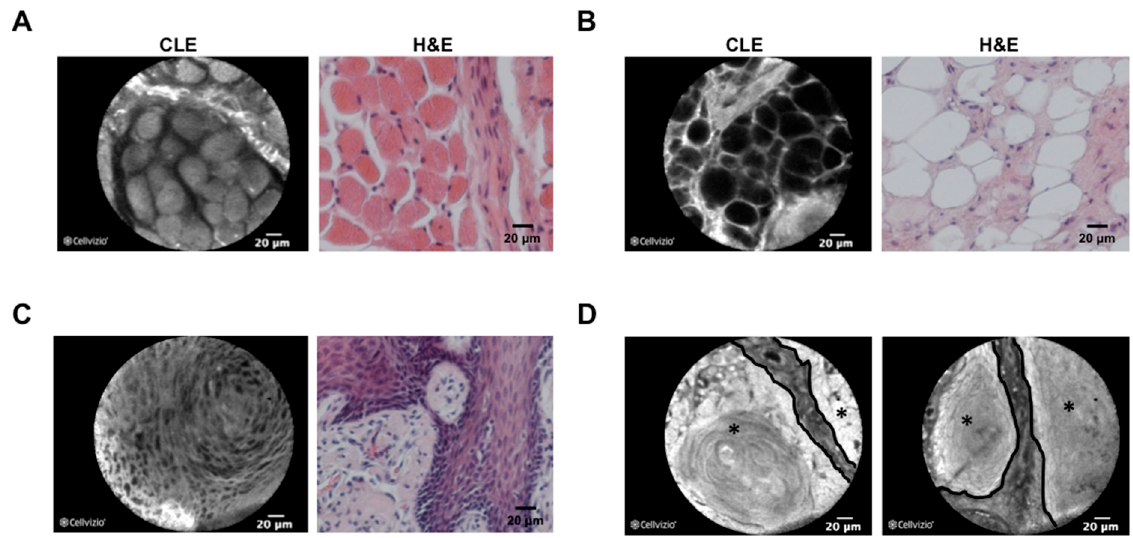
Figure 3. Comparison between CLE and H&E morphology of tissue in the head and neck area. Confocal laser endomicroscopy (CLE) images (left picture, fresh frozen samples) and H&E-stained slides from the respective FFPE tissue are shown for skeletal muscle of the soft palate ( A ), adipose tissue of the cheek ( B ), a nonkeratinizing squamous cell carcinoma of the tonsil ( C ) and a keratinizing squamous cell carcinoma of the tongue ( D ). As shown in ( D ), tumor borders (black line), as well as tumor localization (black star), can clearly be identified using CLE technology. CLE and H&E images are shown in 40× magnification.